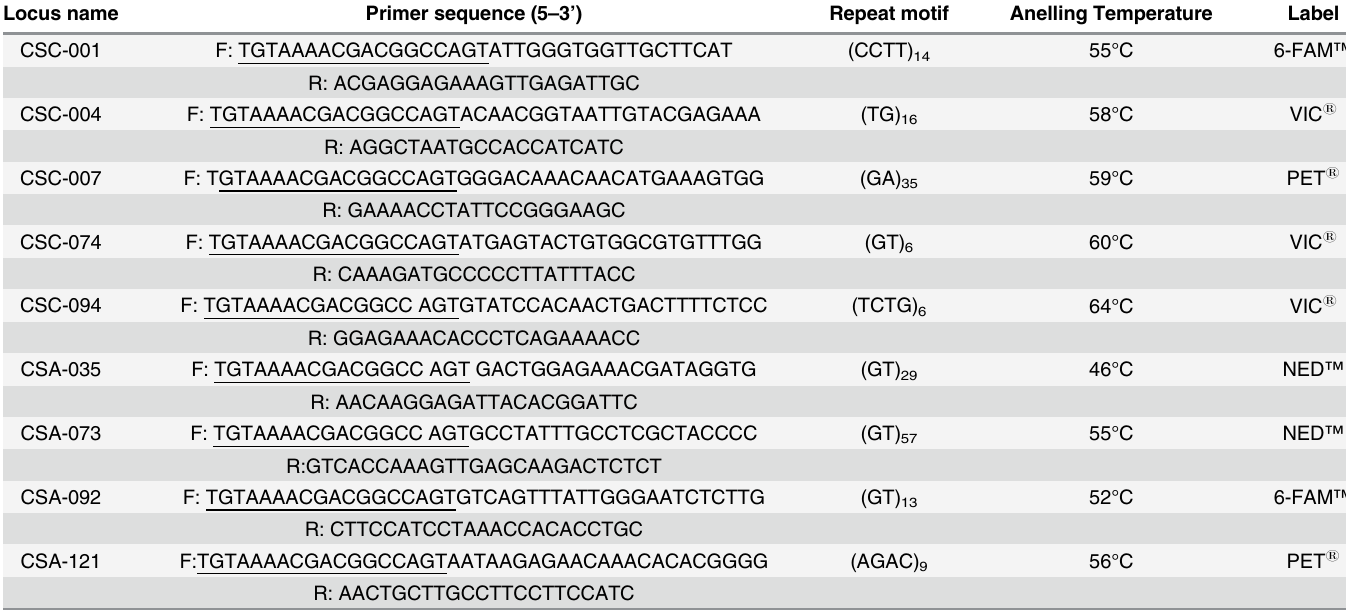
Table 2. Sequences and annealing temperature T (°C) of forward (F) and reverse (R) primers used in PCRs, with underlined sequence in M13 tail, as well as fluorescent dye labels used for genotyping. Locus